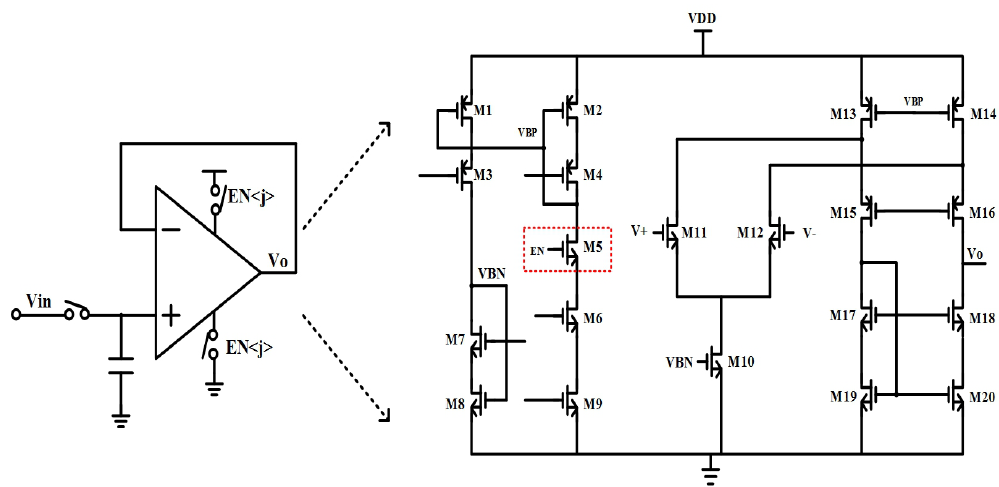
Figure 7. Proposed pulse powered row buffer.